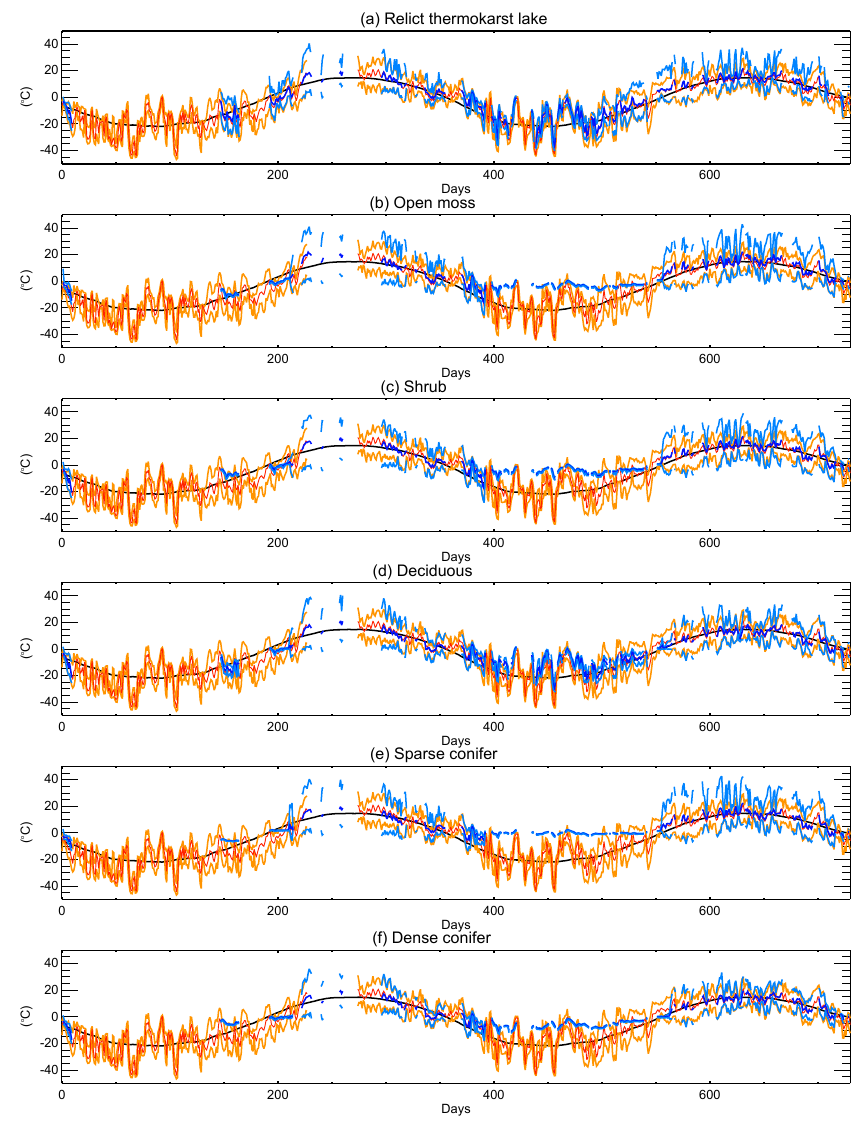
Figure 5. Typical seasonal variations in daily temperatures for the six land cover types: (a) relict thermokarst lake, (b) open moss, (c) shrub, (d) deciduous forest, (e) sparse conifer forest, and (f) dense conifer forest. Plot shows daily maximum and minimum temperatures from the DTS system (blue lines) and the JICS tower (air column at 1.5m height; orange lines) along with daily mean values (dark blue for DTS and red for the JICS tower). The black line shows daily climatology. Data span time period after 13 October